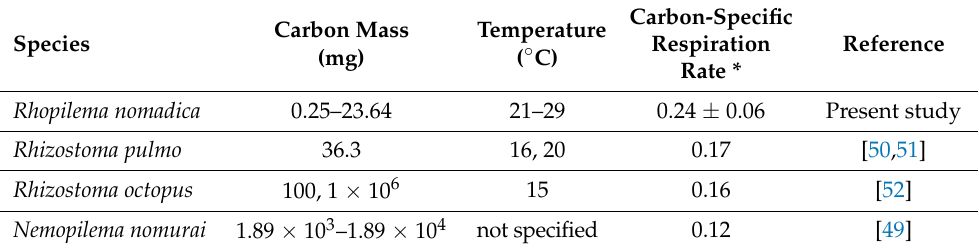
Table 6. Carbon-specific respiration rates of R. nomadica and other Rhizostomatidae species. * Carbon- specific respiration rate = mL O 2 mg C − 1 d − 1 . ± standard deviation. Published mass of similar